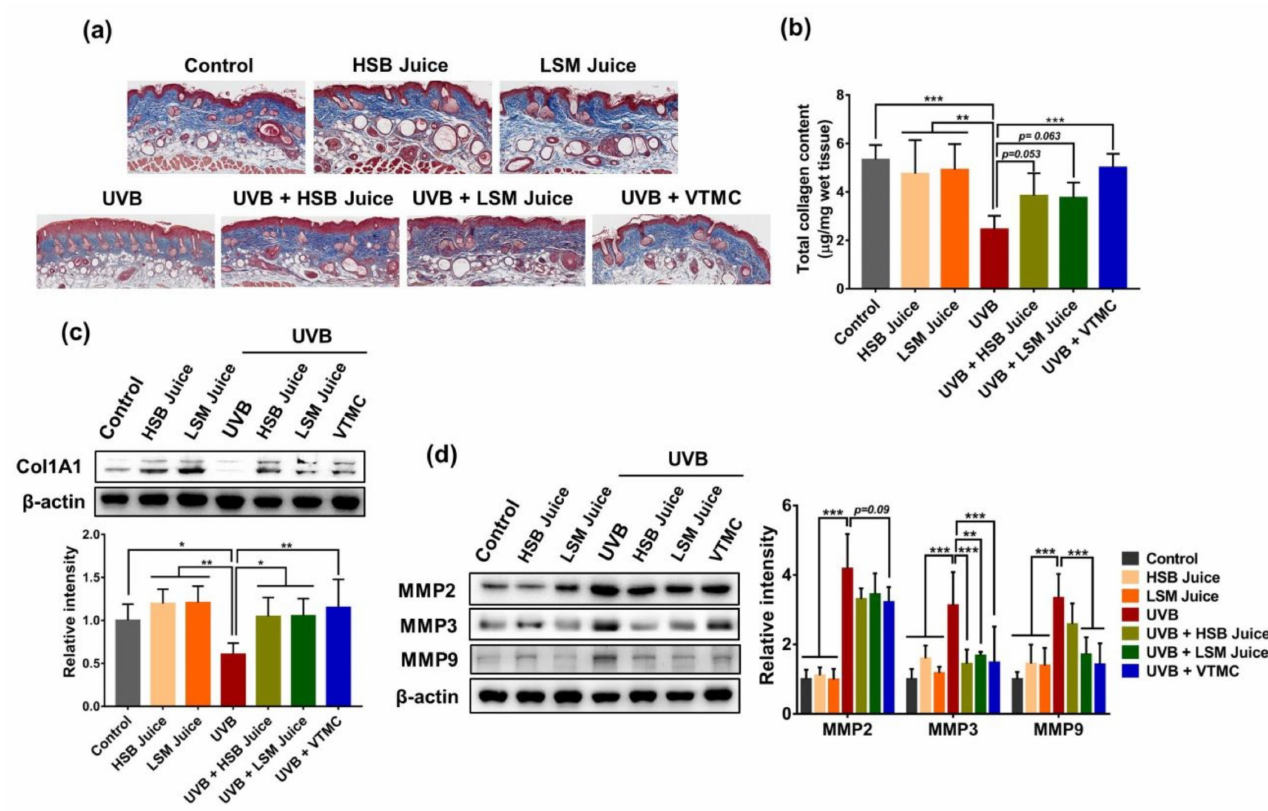
Figure 2. Effects of HSB and LSM sweet pepper juices collagen content in UVB-irradiated SKH-1 hairless mice. ( a ) Representative images of Masson’s trichrome stain for collagen fibber (Blue); ( b ) Total collagen content in skin tissues from each group; ( c ) Protein expression of Col1A1 in skin tissues; ( d ) Protein expression of matrix proteinase (MMP)-2, MMP3, and MMP-9 in skin tissues. Data are expressed as the mean ± SD. * p < 0.05, ** p < 0.01, and *** p < 0.001 values are considered vitamin